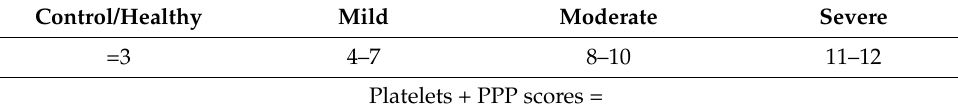
Table 5. Overall microclot and platelet activation score